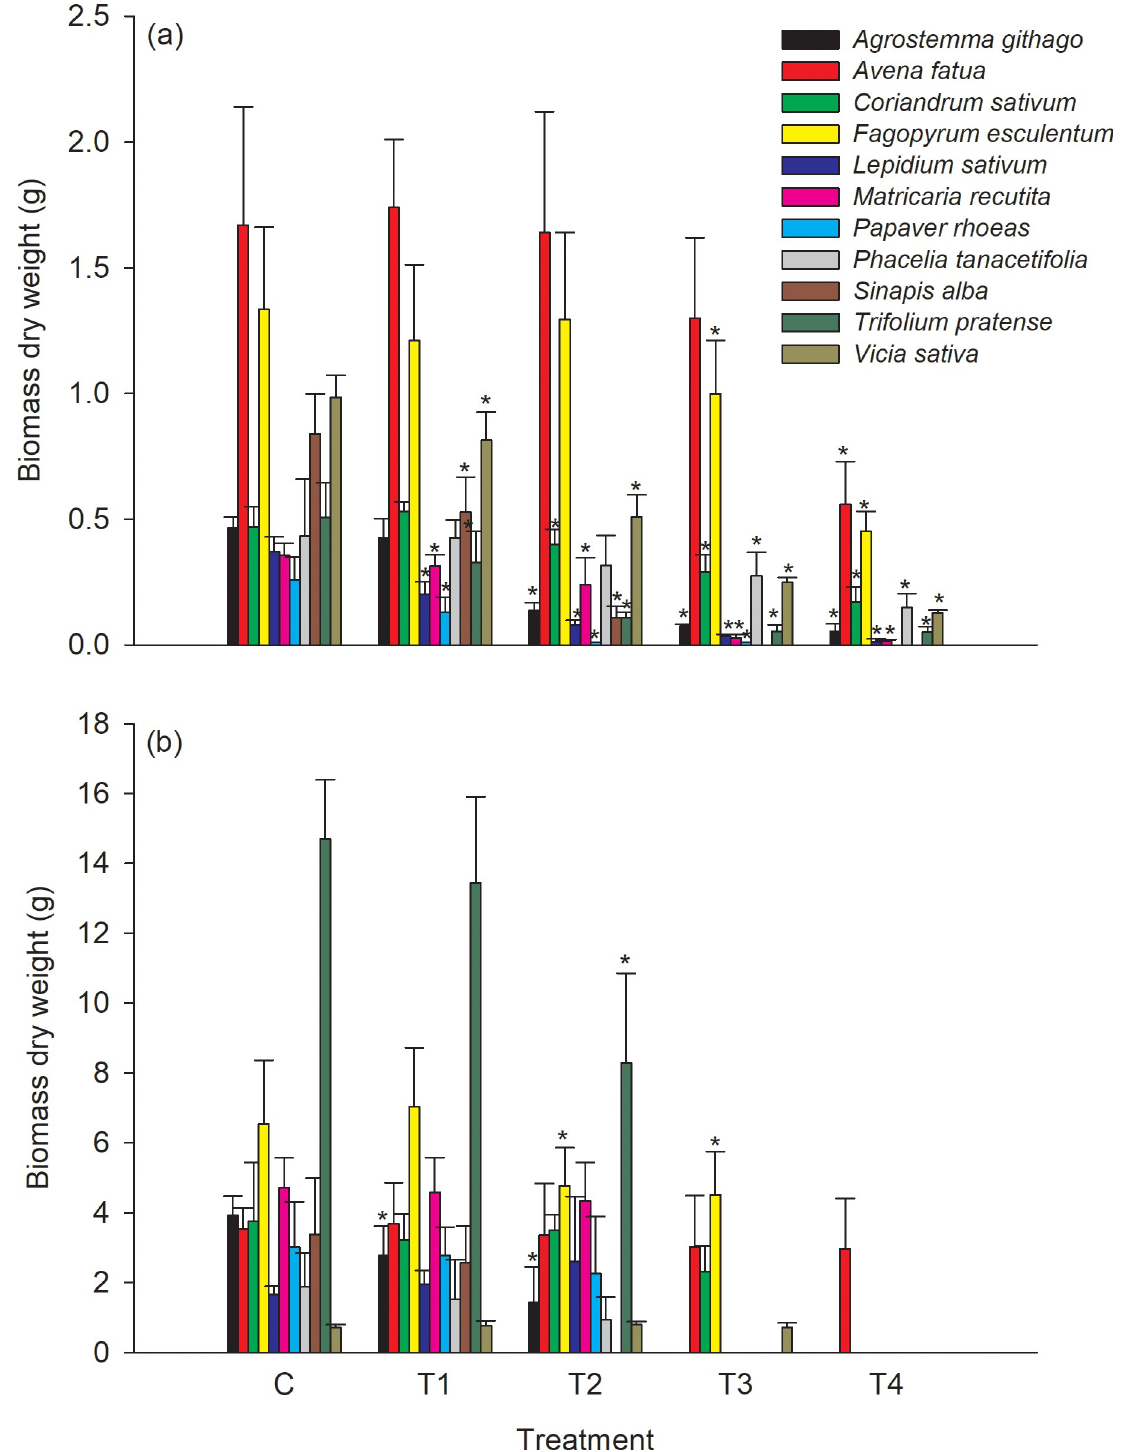
Fig 3. Mean biomass (dry weight) per plant at the vegetative (21 DAA, (a)) and generative (BBCH 89, (b)) growth stage, respectively. Error bars indicate the standard deviation and � indicate a statistical significantly difference to the control (William‘s test or Multiple Welch‘s t-test with Bonferroni-Holm adjustment depending on homoscedasticity) for each plant species ( α = 0.05, one sided smaller). Missing columns within a treatment group indicates that no data could be assessed for the respective plant species.